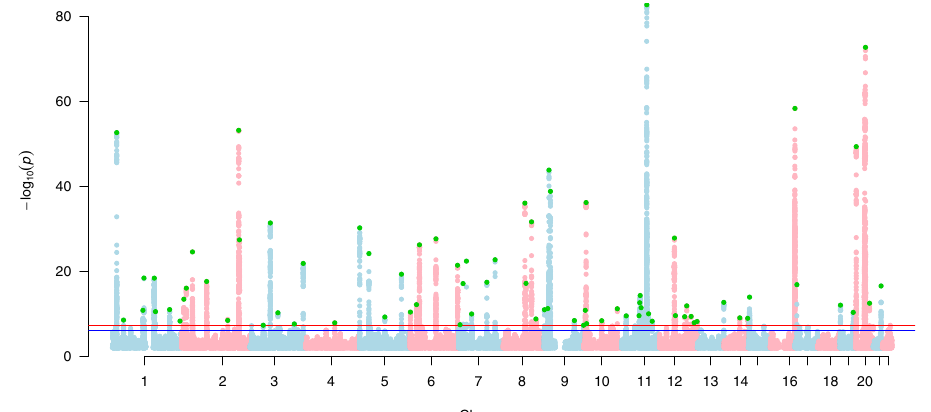
Fig. 2 | Manhattan plot for basal cell carcinoma susceptibility. The Manhattan plot shows the association between SNPs and basal cell carcinoma susceptibility based on the MTAG approach. The Y-axis represents the level of signi fi cance recorded in negative log 10 ( P value) (two-tailed test), whilst the X-axis represents the chromosome 1 – 22, alternated with light blue and light pink colours. The hor- izontalblue line representsasuggestive levelof signi fi canceat P value=10 − 6 , while